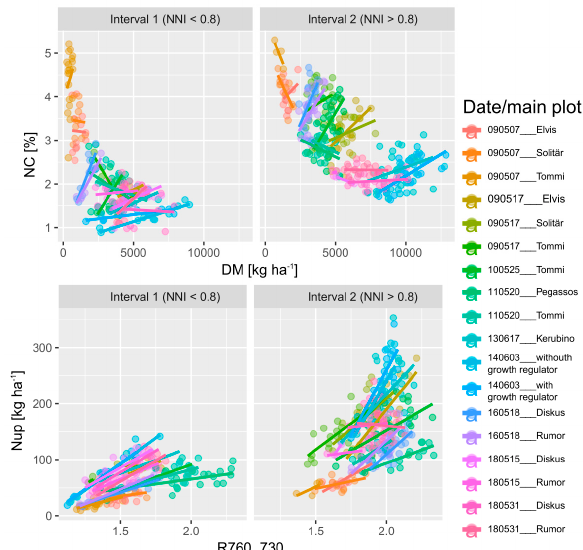
Figure 5. N concentration (NC) plotted against dry matter (DM) of both intervals, based on the NNI-threshold (NNI </> 0.8), and an example of the R760_730 relationships with Nup in both intervals for date*main plot combinations. Regression lines refer to linear fits within intervals. See Supplementary Figure S5 for coefficients of determination for the trait ~ index relationships.